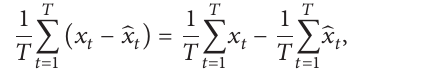
Figure4:Theproceduresofwindspeedforecastingusingthehybrid